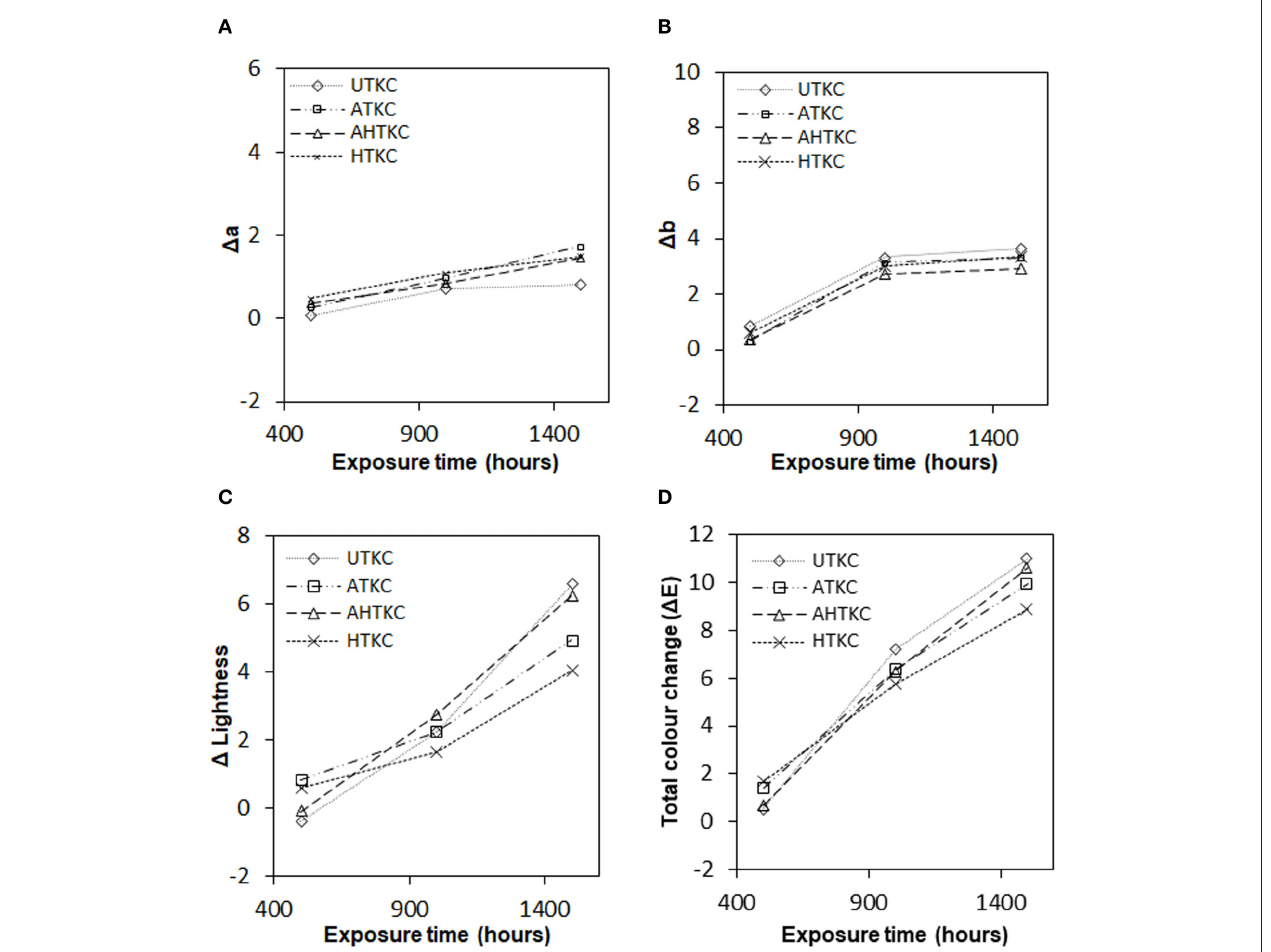
FIGURE 3 | Effect of accelerated weathering exposure on (A) the relationship between green and red color, (B) the relationship between blue and yellow color, (C) the brightness relationship between light and dark, and (D) total color